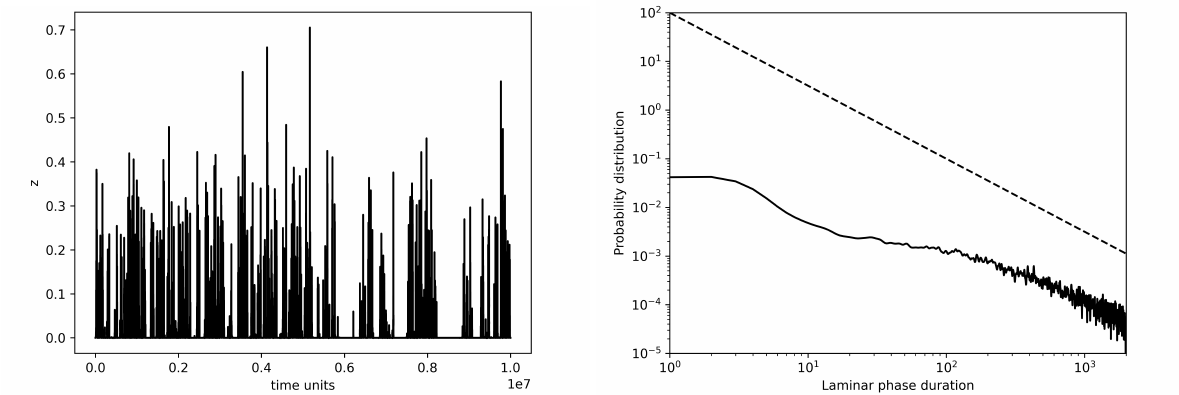
Figure 7. ( Left panel) Time series of z in the case α = 1.5; ( Right panel) Laminar phase durations of the predator/parasitoid z (solid) for stochastic K 0 with α = 1.5. The dashed line is proportional to D − 3 2